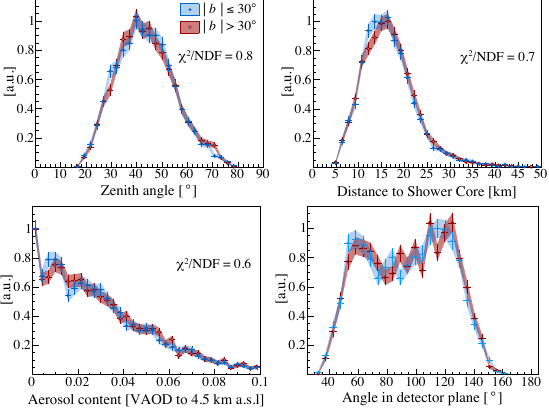
Figure 2: Geometries of the on- and o ↵ -plane samples.